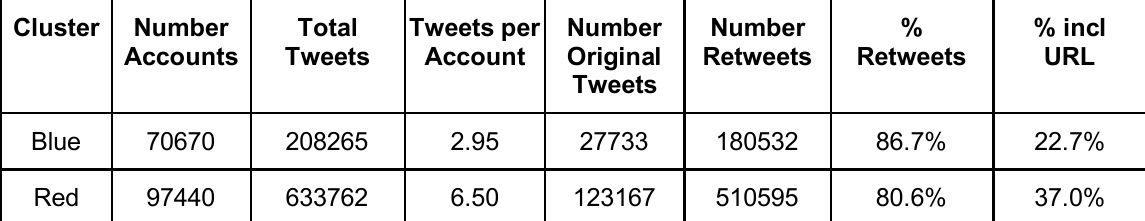
Table 1. Basic Statistics, by Cluster, for the White Helmets Twitter